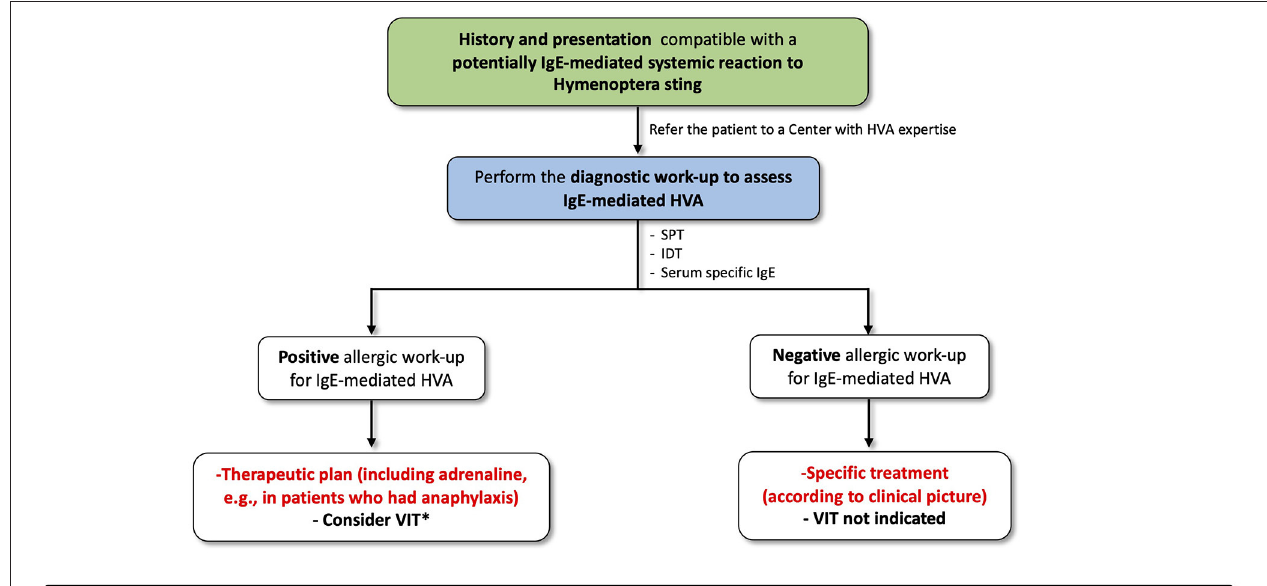
FIGURE 1 | Proposal for a diagnostic and management approach for potentially IgE-mediated systemic reactions to Hymenoptera stings. HVA, Hymenoptera venom allergy; IDT, intradermal test; SPT, skin prick test; VIT, venom immunotherapy. * Especially in subjects who experienced systemic reactions with hemodynamic compromise (hypovolemia and hypoxia) and in case of vital organ involvement (nervous system, cardiovascular and respiratory apparatuses).